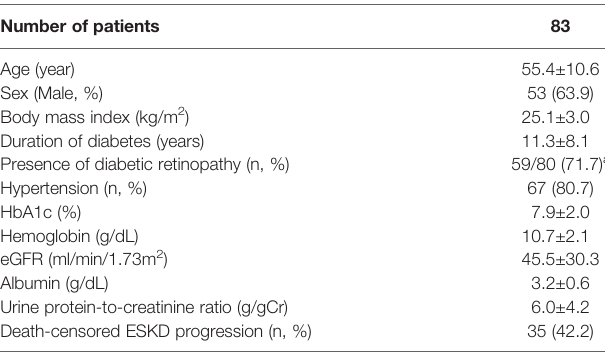
TABLE 1 | Baseline characteristics and clinical parameters of patients with diabetic kidney